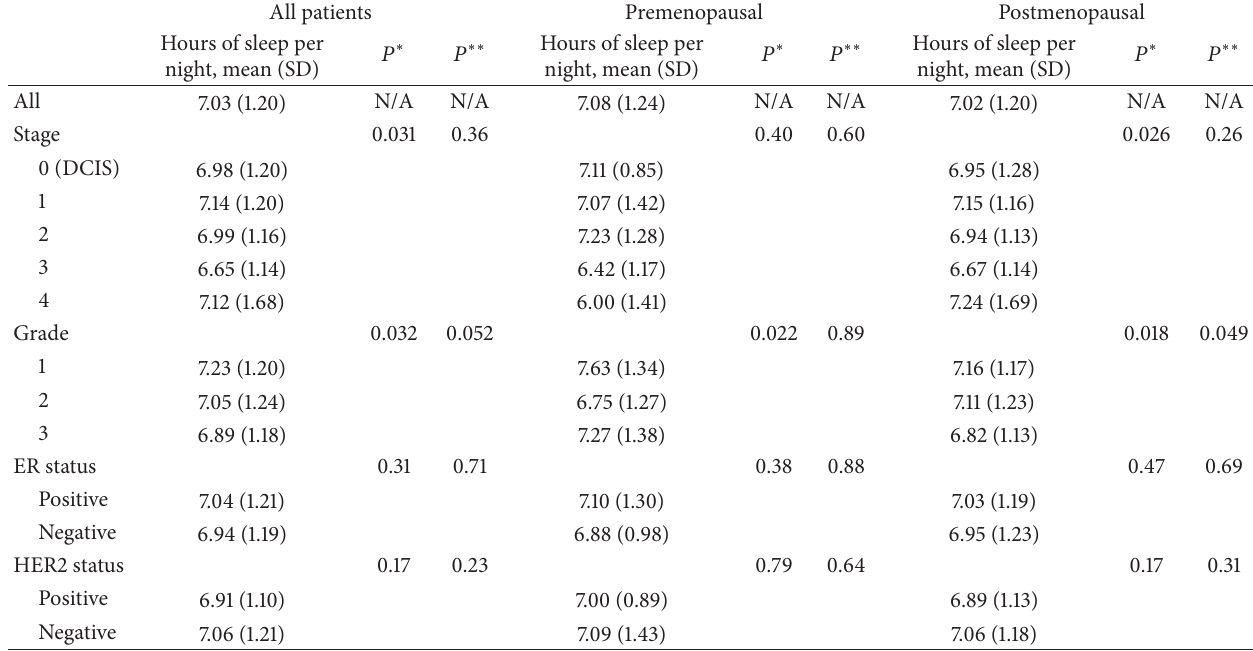
Table 2: Mean self-reported average hours of sleep per night by patient characteristic. All